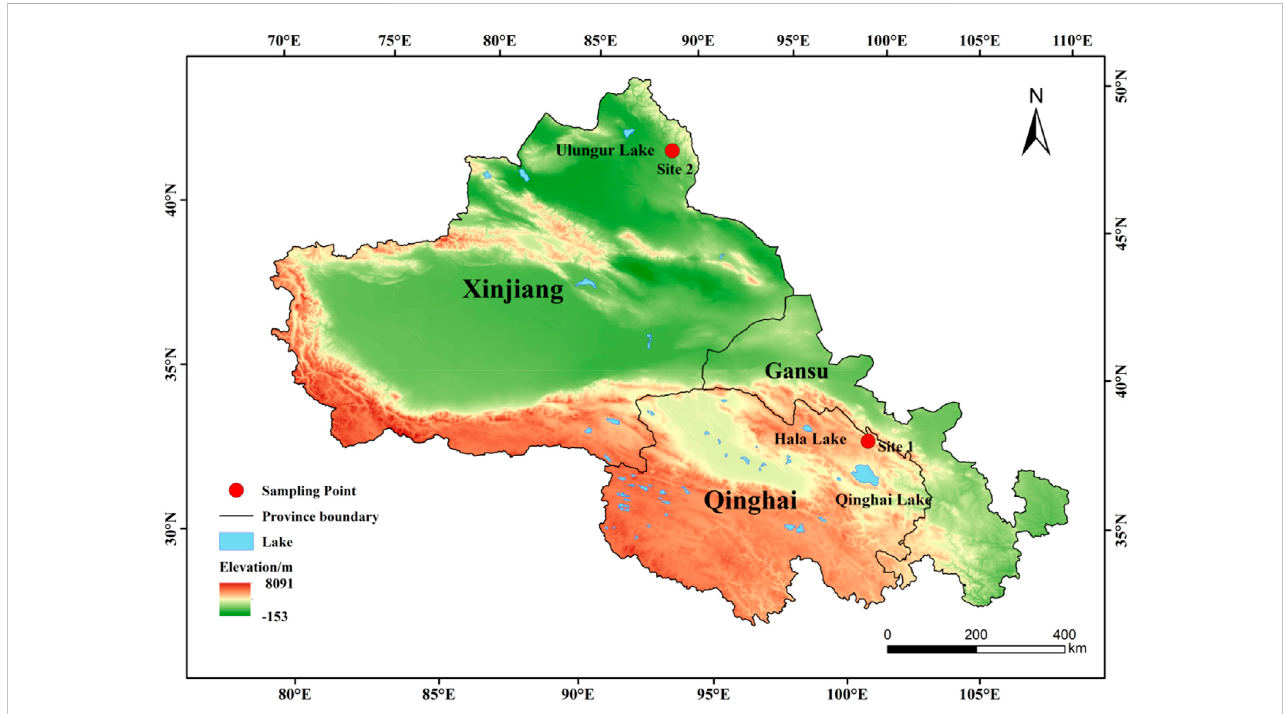
FIGURE 1 Thestudyareaandthelocationofsamplingsites.Site1andsite2arethesamplingpointsnearHeiheRemoteSensingExperimentalResearchStationand Altay Mountain Glacial Snow and Environment Observation and Research Station, respectively.